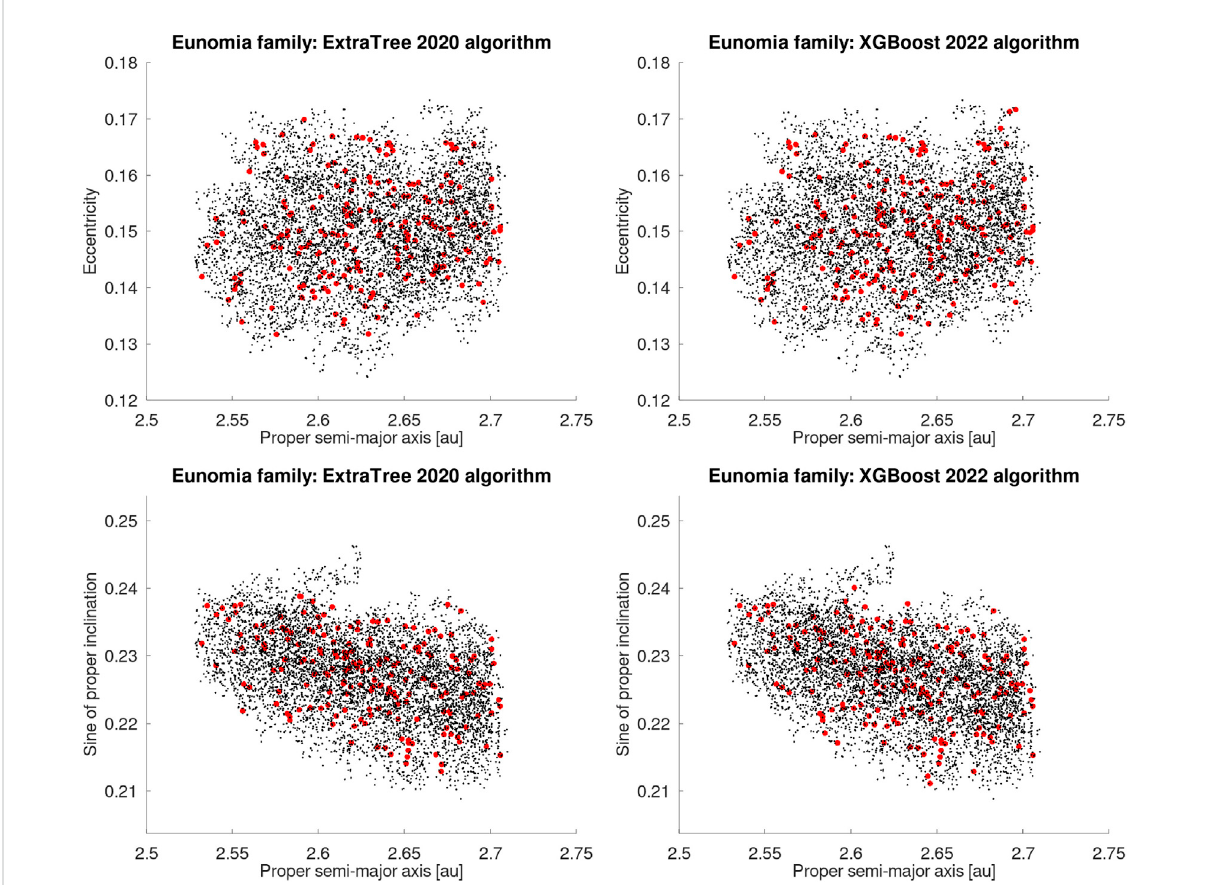
FIGURE 1 Proper ( a , e ) and ( a ,sin( i )) projections of the 15 Eunomia family. Results with Carruba et al. (2020) machine learning algorithms applied to an updateddatabaseofAsteroidFamiliesPortalsiteareshownintheleftpanels,whilethecurrentgeneticalgorithmappliedtothesamefamilydatabase appears on the right. The original familymembers are represented by theblack dots, while theretrieved members are represented by the red